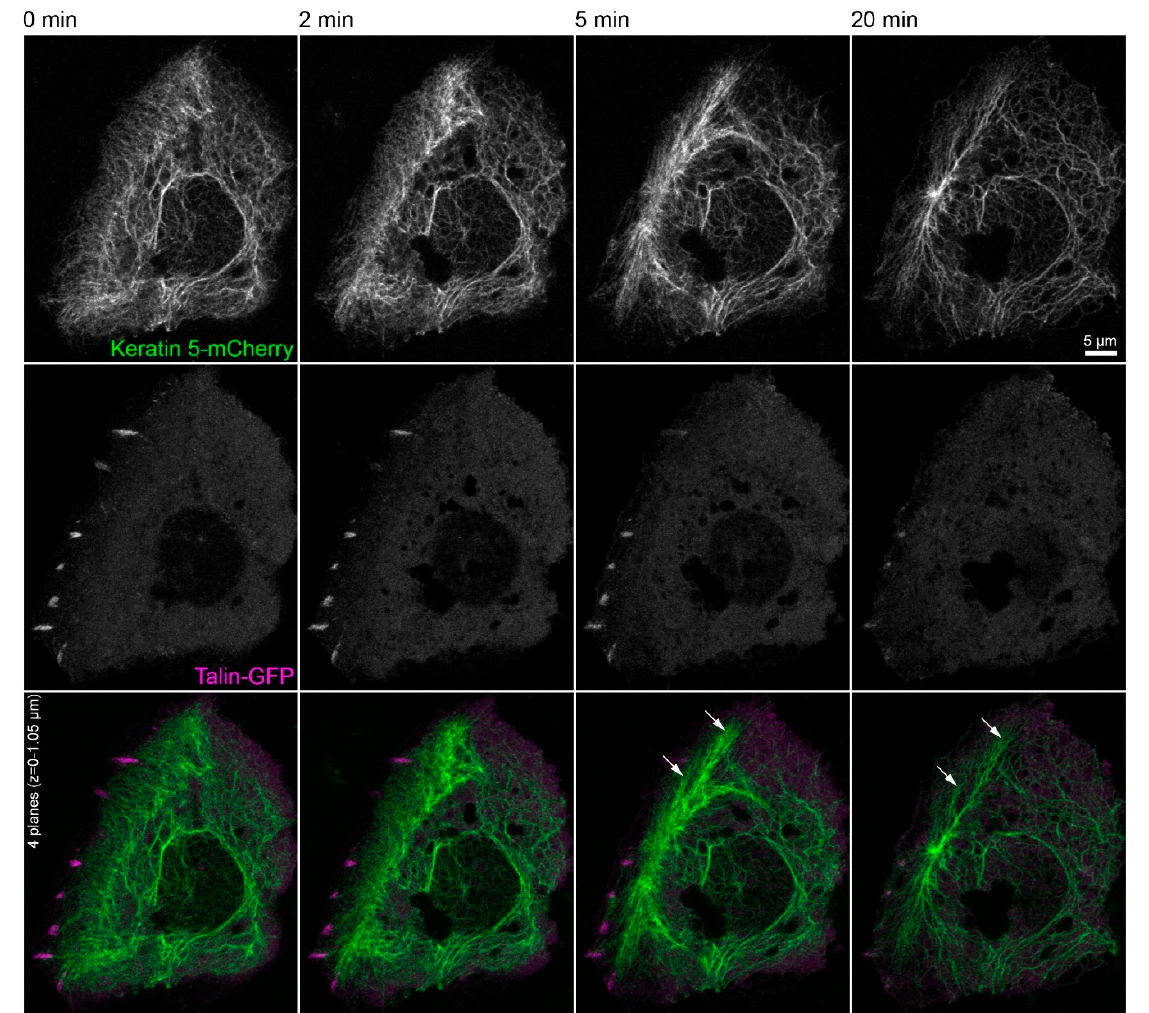
Figure 5. Keratin filament network reorganization is independent of focal adhesions in the absence of actin filaments and microtubules. The images depict keratin 5-mCherry (top) and talin-GFP fluorescence (middle; merge at bottom) in a vital HaCaT keratinocyte before and after treatment with 3 µM latrunculin B and 20 µM nocodazole. The keratin network retracts, bundles, and remains partially attached in the cell periphery (arrows) independent of the continued, though diminishing or even completely vanishing talin-GFP-fluorescence in some regions. All images are maximum intensity projections of the lower focal planes, as annotated in the figure ( n = 3). Note that the cell is next to non-transfected, i.e., non-fluorescent cells. The complete image series is provided in Video S5.